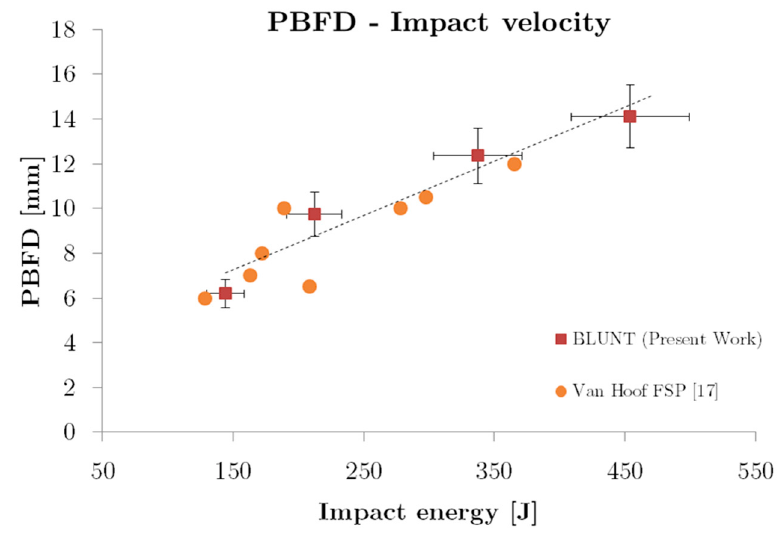
Figure 14. Comparison between existing data on literature and present work.